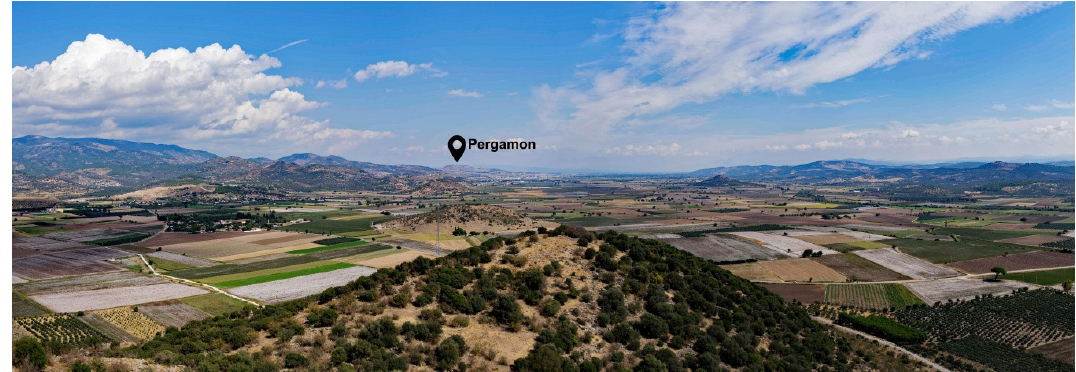
Figure 2. Western lower Bakırçay Valley. View from Kalarga Tepe (Teuthrania) to the east. Background: the city hill of Pergamon, the Kozak Mountains (left) and the Yund Da ğ ı Mountains (right).